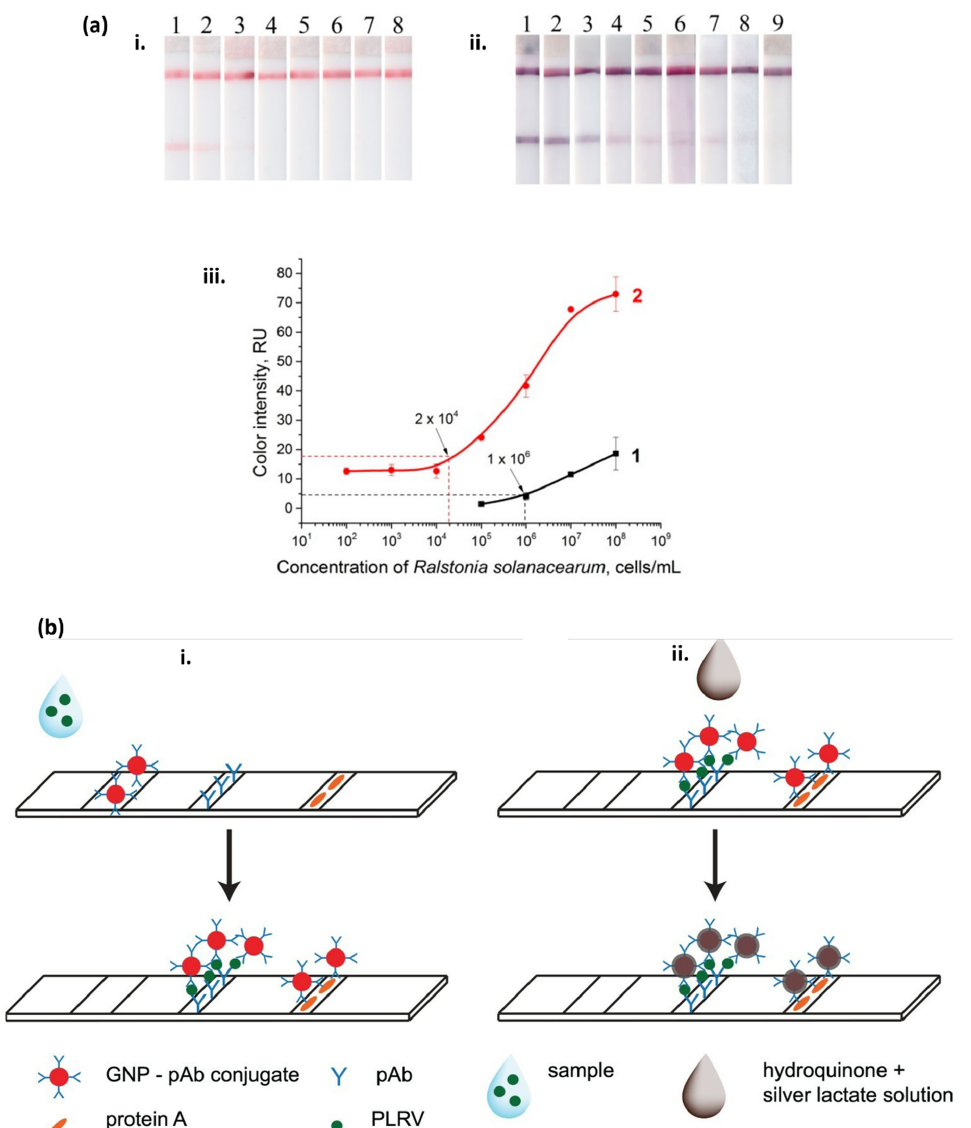
Figure 5. ( a ) Testing of LFIA ( i ) before and ( ii ) after enlargement. Here, strips #1–9 correspond to 10 8 , 10 7 , 10 6 , 10 5 , 10 4 , 10 3 , 10 2 , 10 1 , and 0 cells/mL of Ralstonia solanacearum, respectively . ( iii )